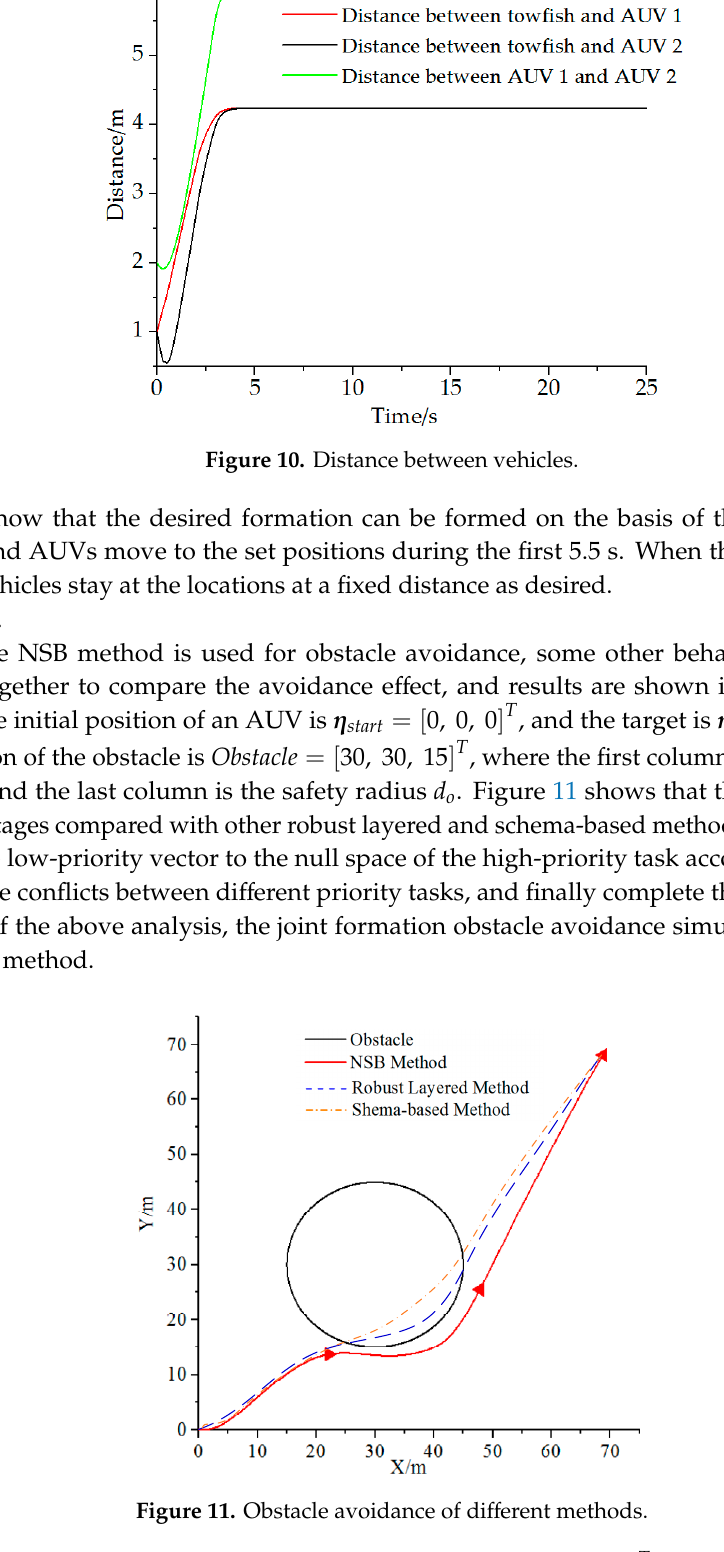
Figure 11. Obstacle avoidance of different methods.